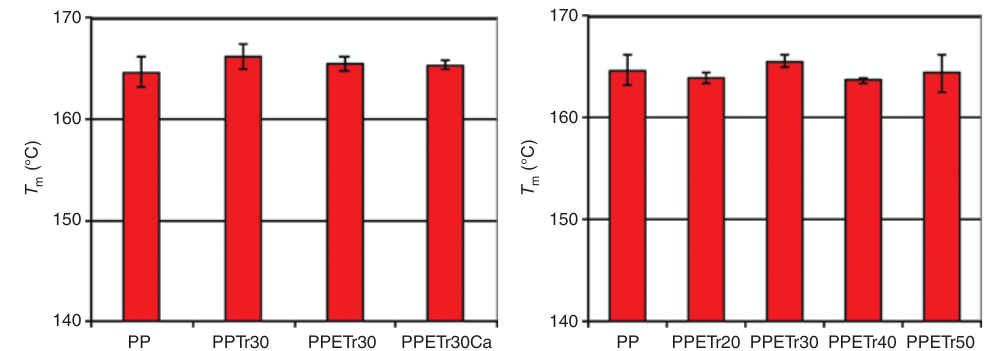
Figure 6 Melting temperature of PP triticale composites.